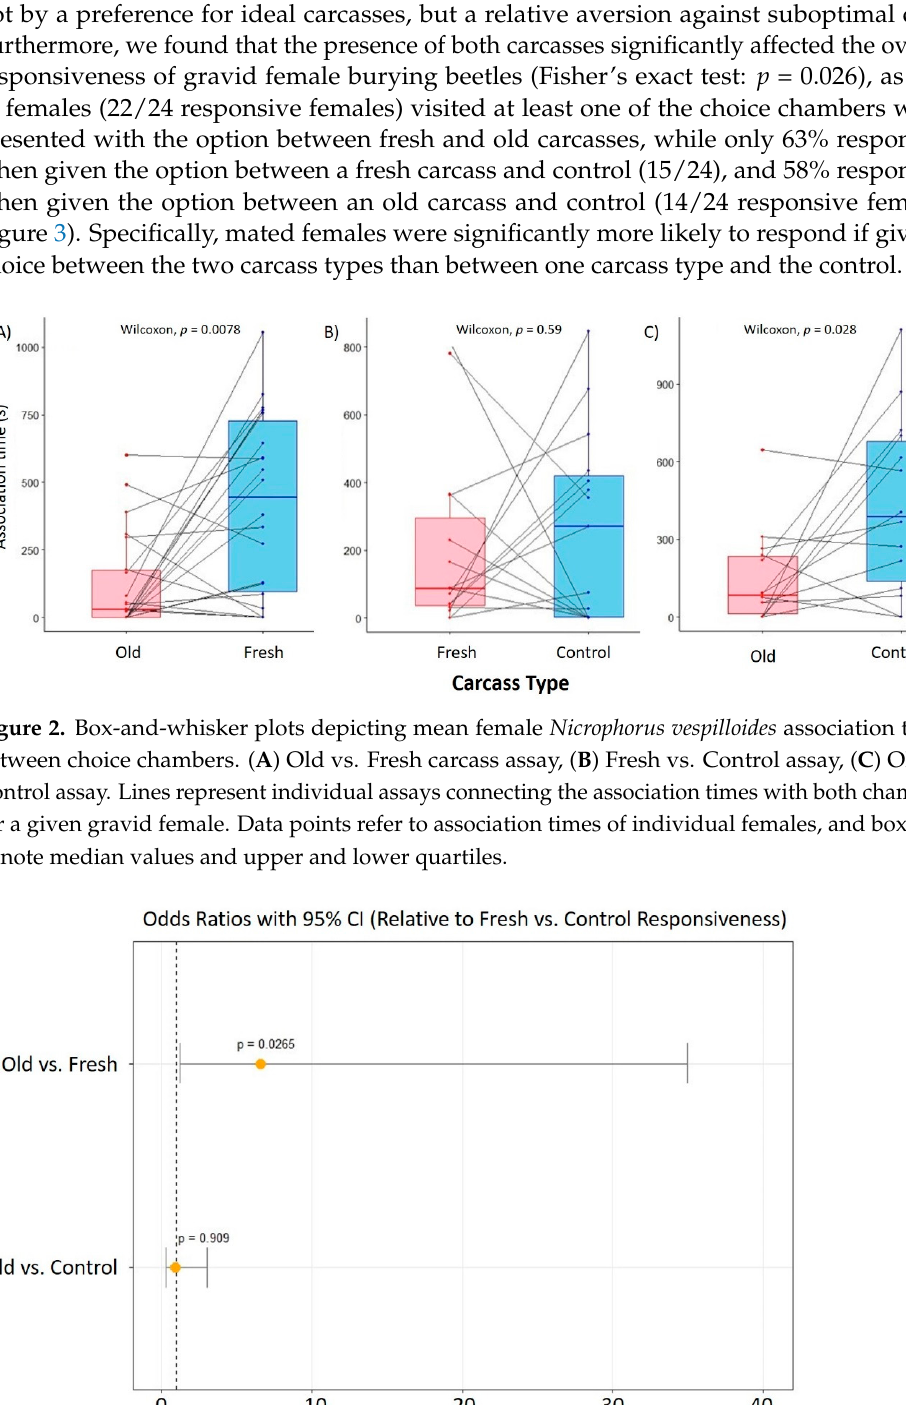
Figure 3. Odds of an individual gravid female N. vespilloides responding and showing a preference when presented with both an old and fresh carcass, a fresh carcass only, and an old carcass only. Odds ratios are presented relative to Fresh vs. Control assay (vertical line). Data points represent mean odds, and error bars represent the 95% CI.